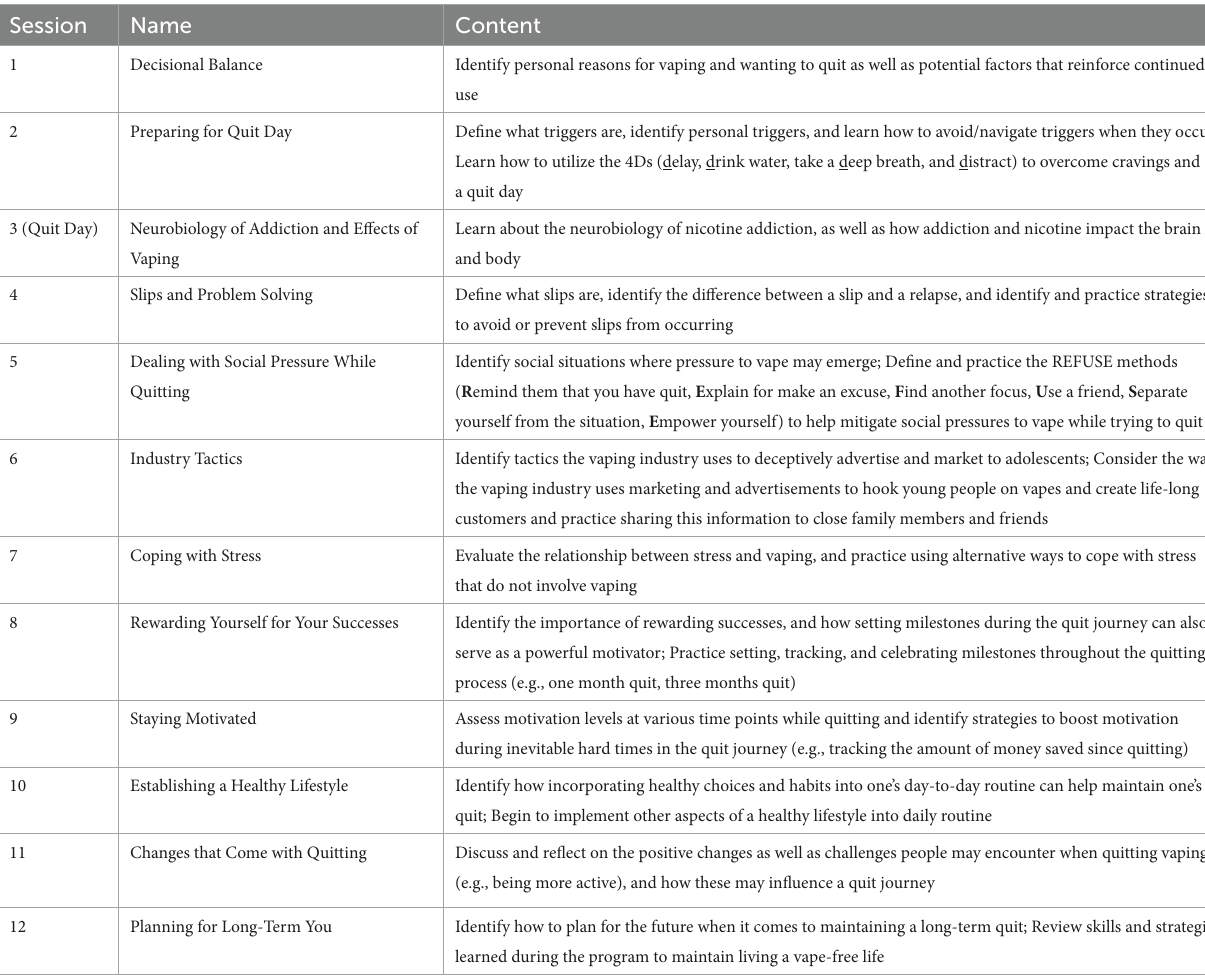
TABLE 3 Overview of the brief behavioral counseling intervention for vaping cessation (Quit